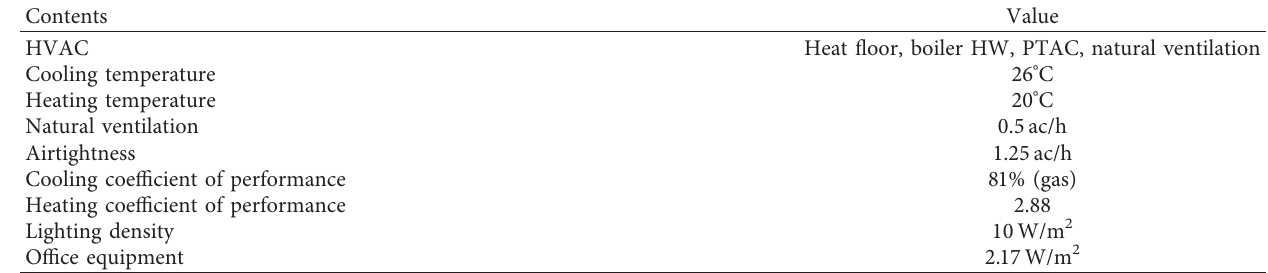
Table 10: Setting of simulation.